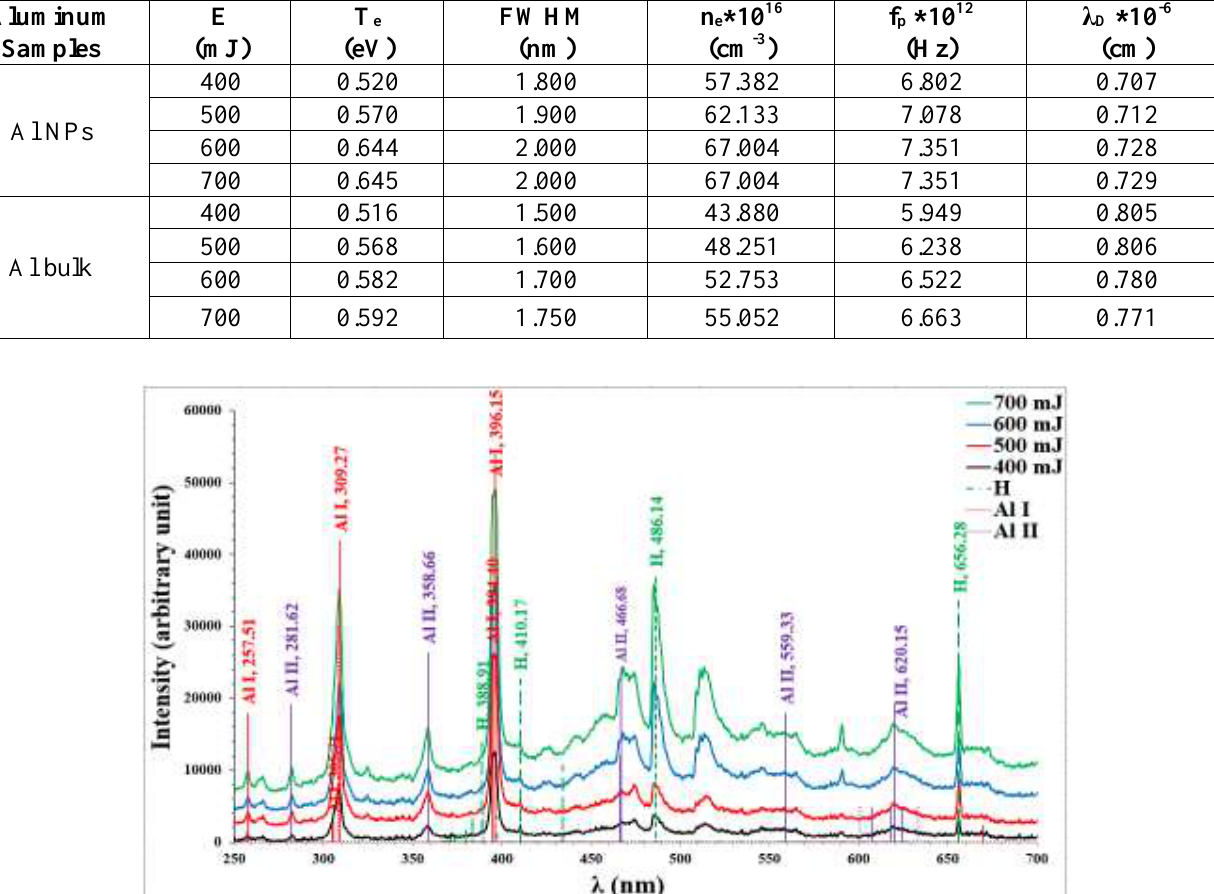
Figure 5: The emission spectra of the laser-induced Al NPs target with various laser energies (400, 500, 600, and 700 mJ).